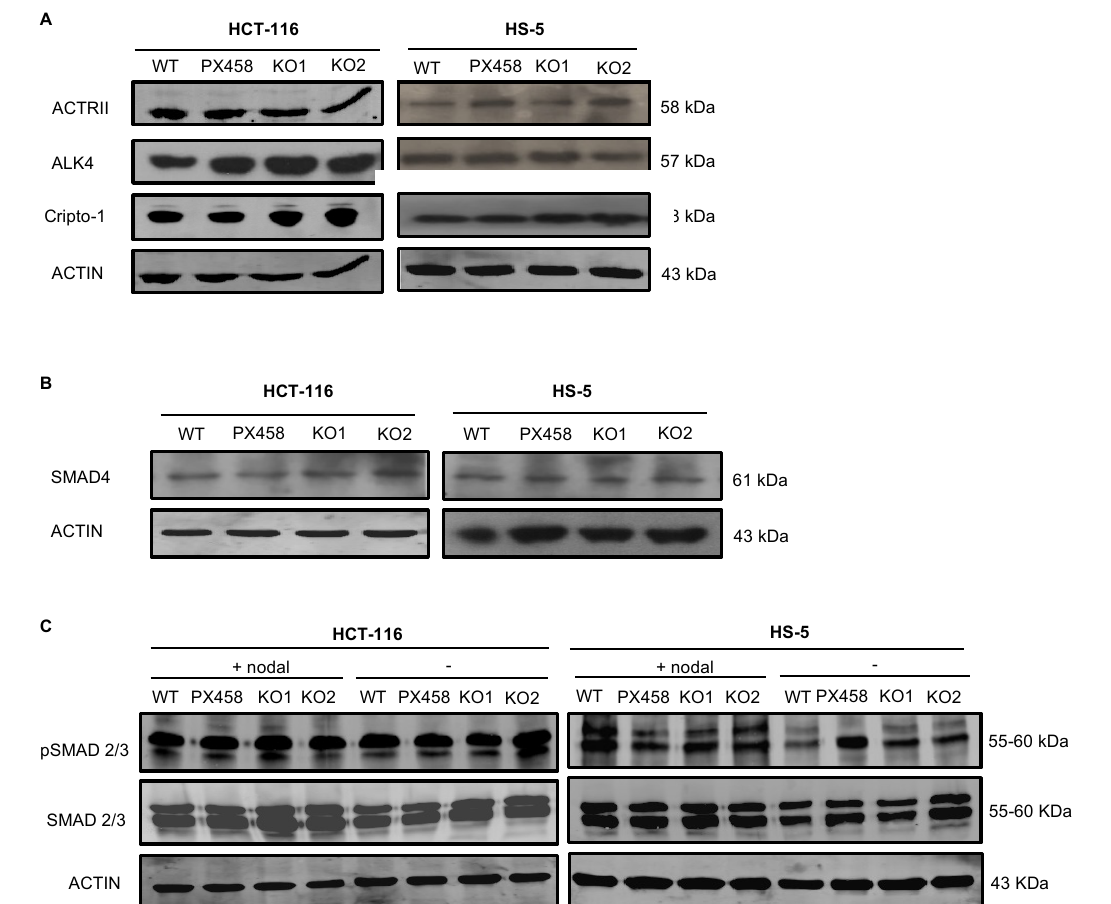
Figure 4. Expression levels of proteins involved in the Nodal signaling pathway in NOMO1 - KO and control clones. ( A ) Expression of ALK4 and ACTRII Nodal pathway receptor proteins and the co-receptor Cripto-1 detected by WB. ( B ) Protein expression of SMAD4. ( C ) Levels of Smad2/3 and p-Smad2/3 protein expression in untreated clones or clones treated with rhNodal (300 ng/mL) for 24 h.